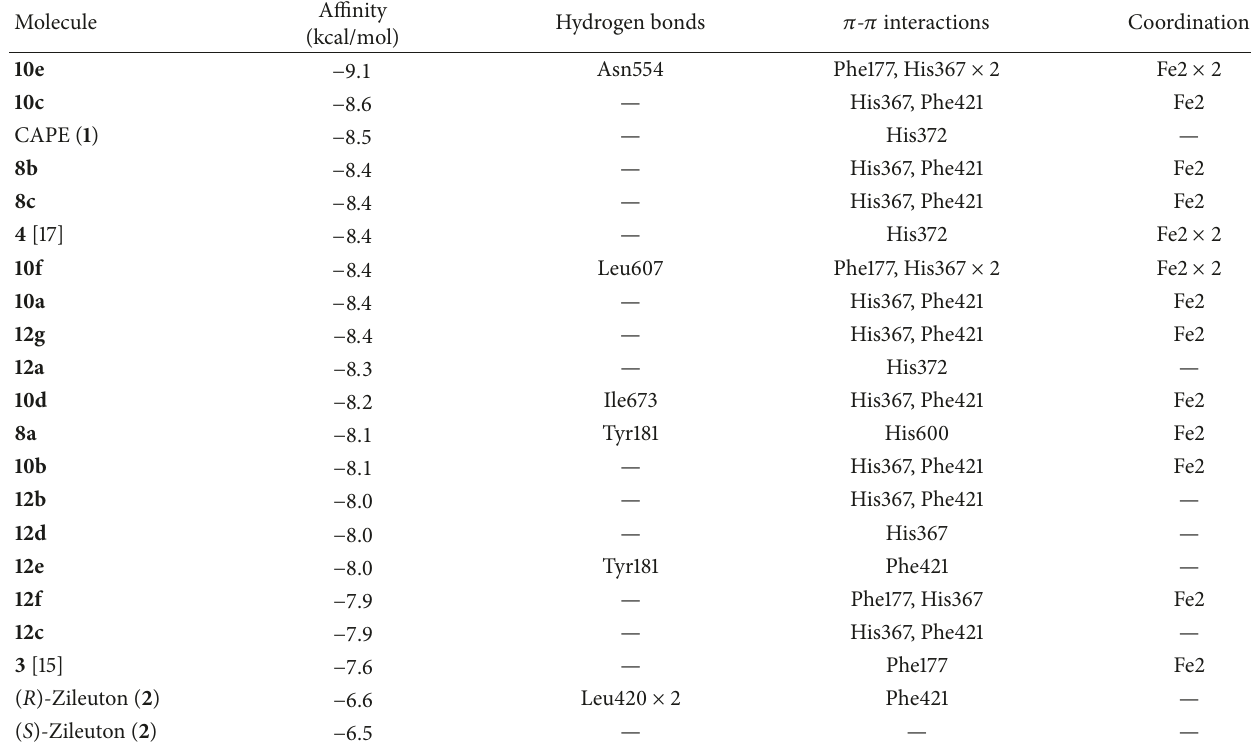
∗ Molecular docking was performed on a modified 5-LO protein (PDB code: 3O8Y). Figure 7 showing the double bond in “ 𝑍 ”-form is a result of the software used to generate the 2D image, LigPlot. The file given by the molecular docking software has the “ 𝐸 ”-form